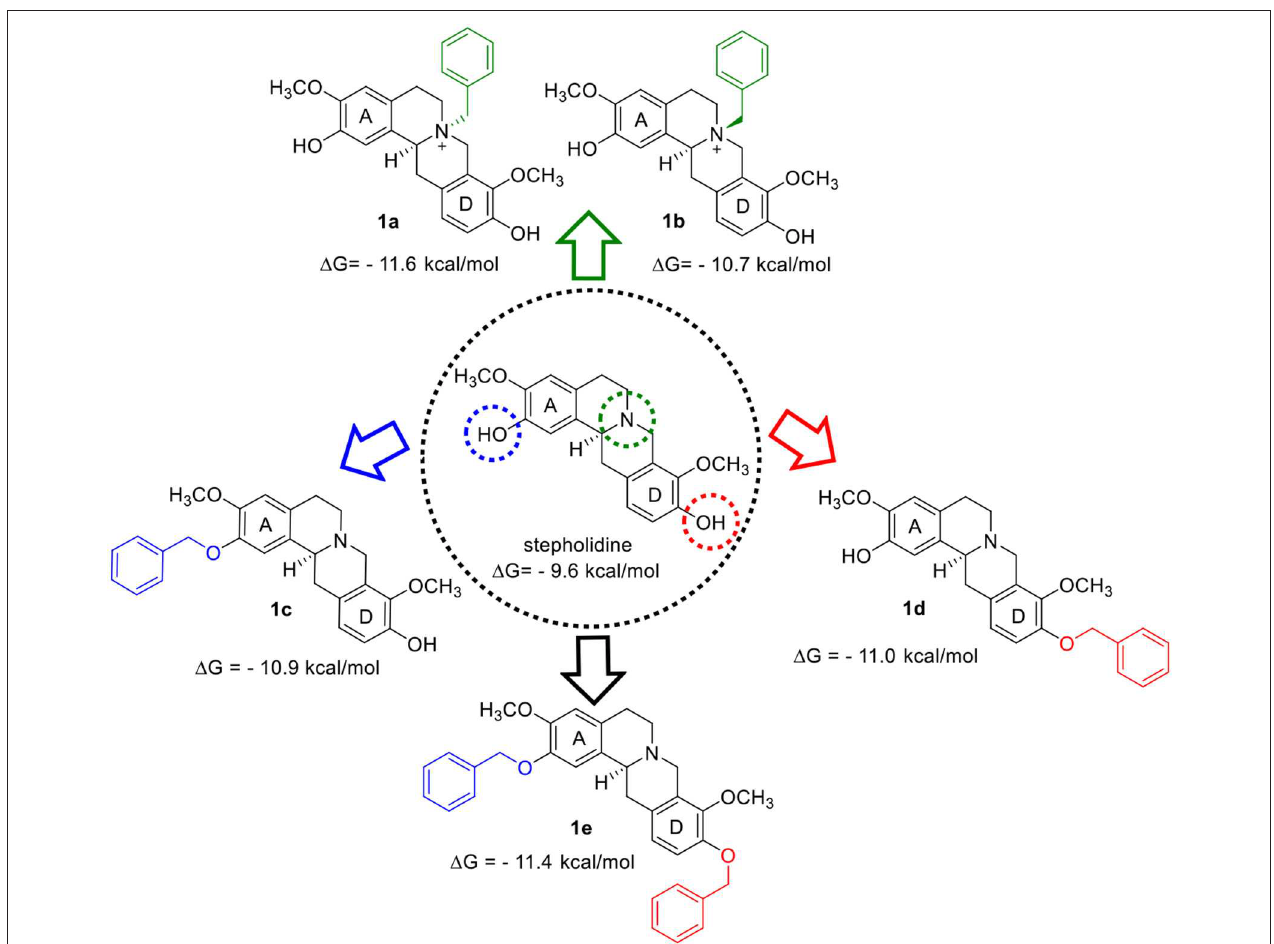
FIGURE 1 | Design of the AChEIs from the benzylation of